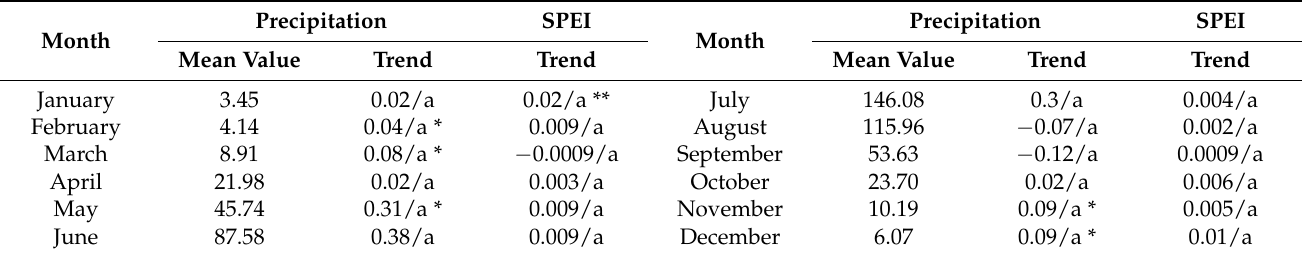
Table 4. Monthly average precipitation and the trend of precipitation and SPEI within the SHRB.